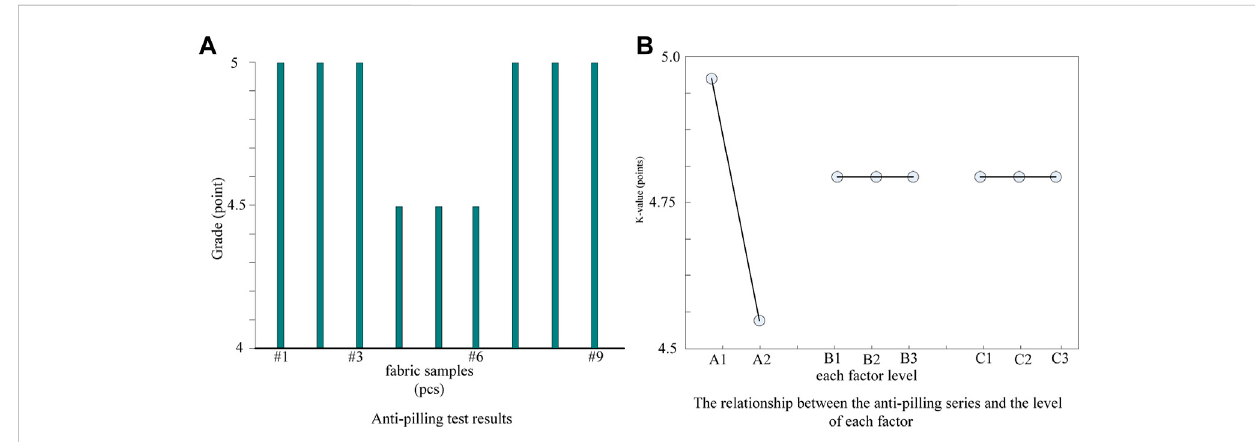
FIGURE 8 Test results of anti-pilling function. (A) Anti-pilling test results. (B) The relationship between the anti-pilling series and the level of each